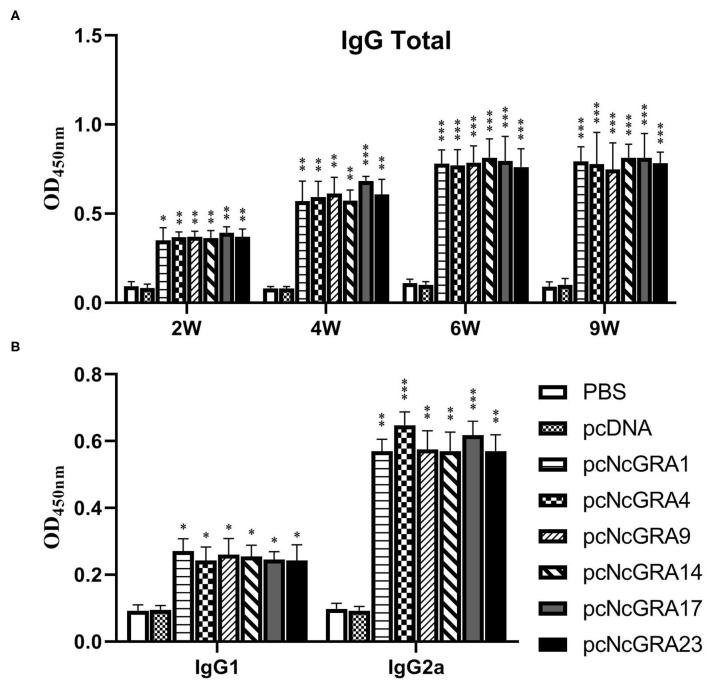
Time course assessment of humoral immune levels against pcNcGRAs in mice. (A) IgG total levels of serum from immunized and control mice at weeks 2, 4, 6, and 9. (B) IgG1 and IgG2a levels of serum from immunized and control mice at week 6. Each bar represented the mean ± SD from four mice per group. Significance was analyzed between experimental groups and the PBS control group and presented as *p < 0.05, **p < 0.01, or ***p < 0.001.